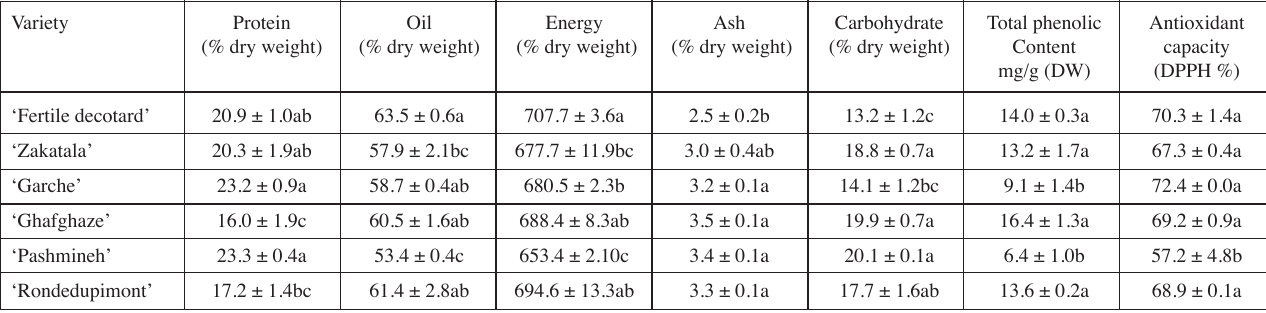
Tab. 1: Some nutritional properties of hazlnuts ( Corylus avellana L.)